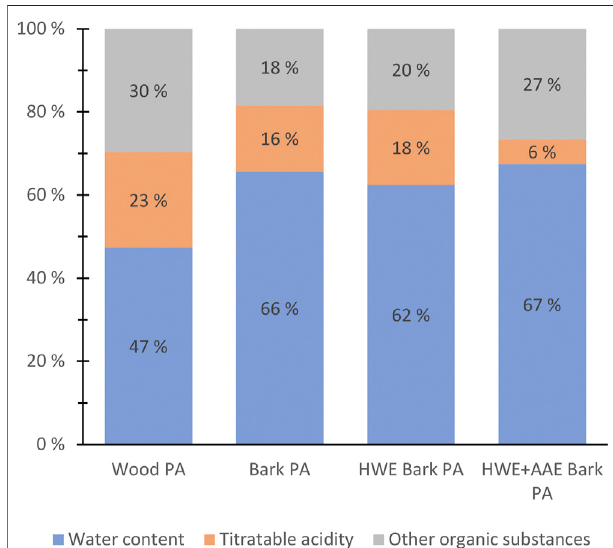
FIGURE 5 | Basic chemical composition of pyroligneous acids (PAs) produced from wood, bark, hot water-extracted (HWE) bark or HWE+alkaline alcohol-extracted (AAE) bark of hybrid